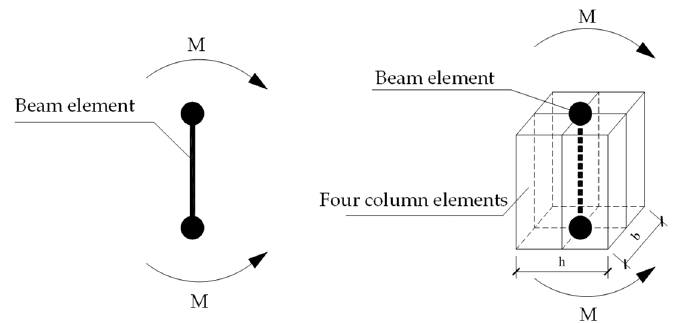
Figure 4. Model of pile composed of beam element and column element. Table 4. Physical parameters of connection beam at pile top and mass. Table 5. Material parameters of pile used for